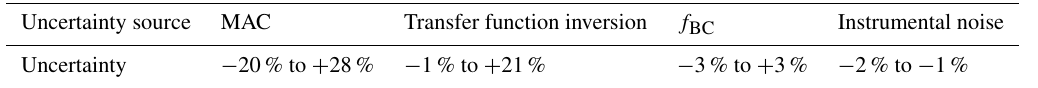
Table 1. The uncertainty in the m eBC , bulk , AAC − AE33 , 200 − 720 that resulted from the MAC lookup table, transfer function inversion, f BC and instrumental noise. MAC f